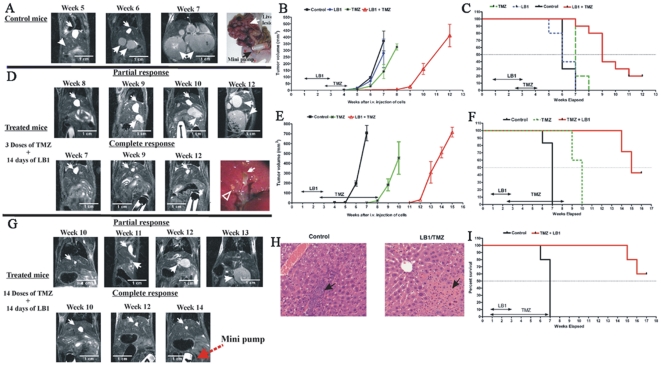

In vivo anti-tumor activity of LB1 and TMZ and histological examination.Effects of treatment upon growth and molecular changes in hepatic tumors: (A) MRI images of untreated mice at weeks 5, 6, and 7 following intravenous injection of MPC cells and a photomicrograph showing the growth hepatic lesions and Alzet minipump. Barbed arrow indicates the gall bladder. Plain arrows indicate the same tumor nodules over time. (B) Inhibition of total hepatic tumor volume by LB1 alone at 1.5 mg/kg daily for 14 days by c.i. administered at 5th day after MPC cells injection; TMZ alone at 80 mg/kg for 3 doses administered at 15th day after MPC cells injection; and, combination of both drugs. (C) Survival curve combining the data from the study depicted in (B) a total of 10 control animals, 10 animals with combination treatment LB1 and TMZ, 5 animals with TMZ alone, and 5 animals with LB1 alone. Kaplan-Meier analysis revealed that survival following LB1 plus TMZ was significantly greater than with LB1 alone and TMZ alone (log rank, P<0.0001). (D) MRI images of mice, treated with the combination of LB1 by c.i. for 14 days and 3 doses of TMZ, at week 7, 9, and 12. Partial response of treatment is presented with delayed appearance of hepatic tumors compared to untreated group. Complete response presents absence of hepatic tumors after treatment. A photomicrograph of the liver of one treated animal at week 12, showing the absence of gross tumor, and the presence of fibrous scar tissue (arrows). (E) Inhibition of estimated total hepatic tumor volume by combination treatment of LB1 and TMZ. LB1 at 1.5 mg/kg daily for 14 days by c.i. administered at 5th day after MPC cells injection and TMZ at 80 mg/kg every 3 days for 14 doses beginning on 15th day after MPC cells injection (with combination or alone). (F) Survival curve combining the data described in E. Total of 12 control animals, 5 animals for TMZ and 7 animals for combination treatment LB1 and TMZ. Survival of animals with combined treatment were significantly greater compared to controls (log rank, P<0.0001). (G) Serial MRI images of mice, treated with the combination of LB1 and 14 doses TMZ with partial and complete responses. (H) Histologic features of liver PHEO at week 12 stained with H&E receiving no treatment or LB1 by c.i. and three doses of TMZ as described in D. Untreated animals showed intrahepatic deposits of cancer cells whereas the liver of an animal receiving both drugs that had no gross evidence of tumor revealed normal parenchyma and fibrous tissue, believed to be scarring at former sites of tumor masses. (I) Survival curves of animals treated with LB1 and 14 doses of TMZ when administration started at the same time, on day 5 after MPC cells injection. (n = 5 treated animals with LB1 plus TMZ, n = 5 for controls; log rank, P = 0.0035).